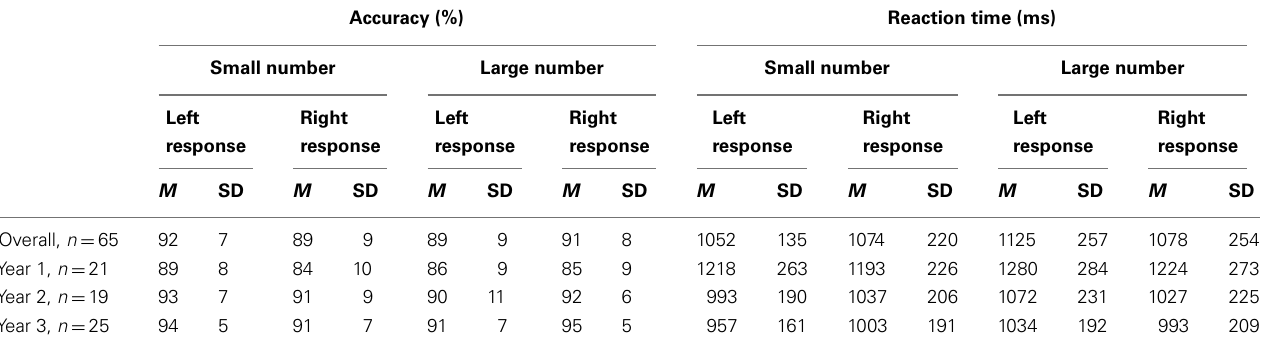
(1063 ± 227 ms). For the main effect of year, post hoc analysis indicated that the RTs of Year 1 children (1229 ± 260 ms) were significantly slower than the RTs of Year 2 (1032 ± 211 ms) and Year 3 (997 ± 188 ms; p s < 0.01). In RT the SNARC effect (Mag- nitude × Response Side) was also significant [ F (1, 62) = 8.58, responded 47 ms faster with the right hand than with the left hand ( p = 0.02) whereas small numbers were responded to 22 ms faster with the left hand than with the right hand ( p = 0.49; Table 3 ). Separate year group